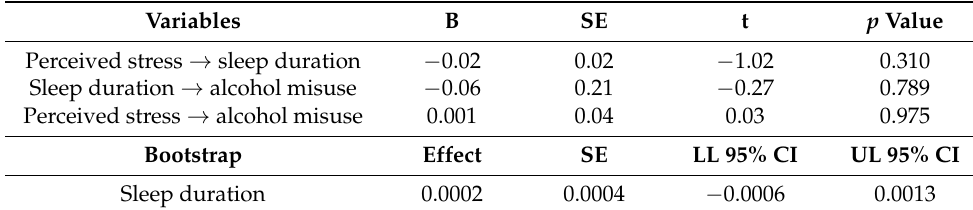
Table 12. Model 4 mediation